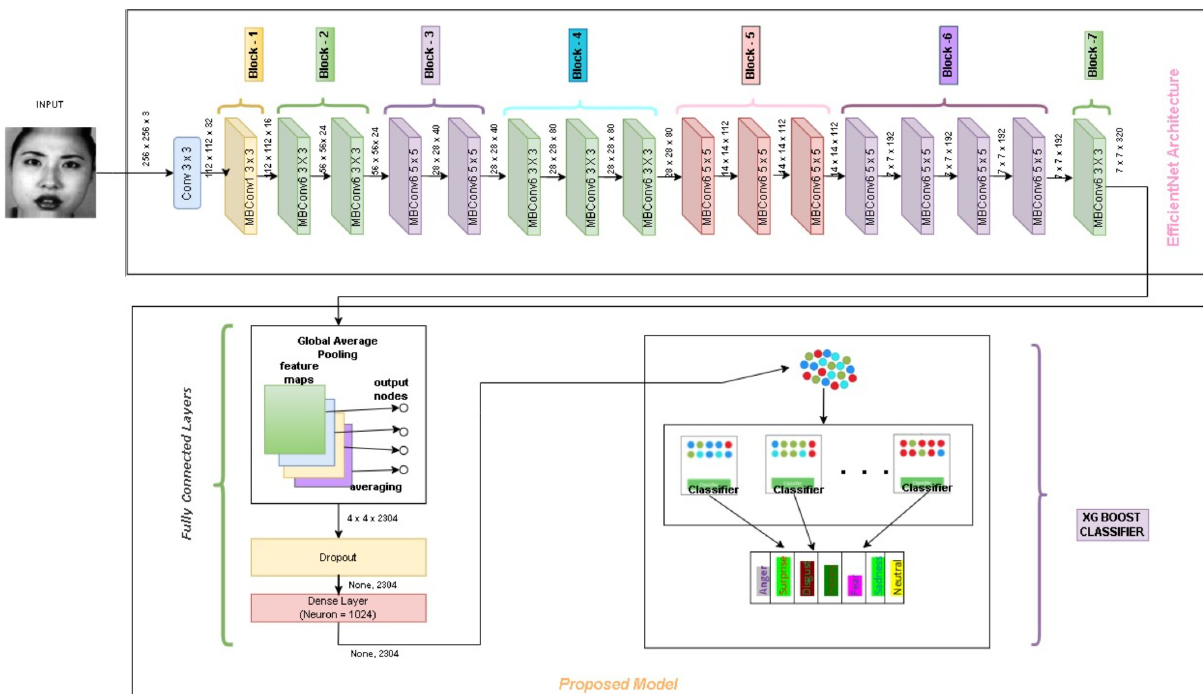
Figure 3. Proposed FER model based on Transfer